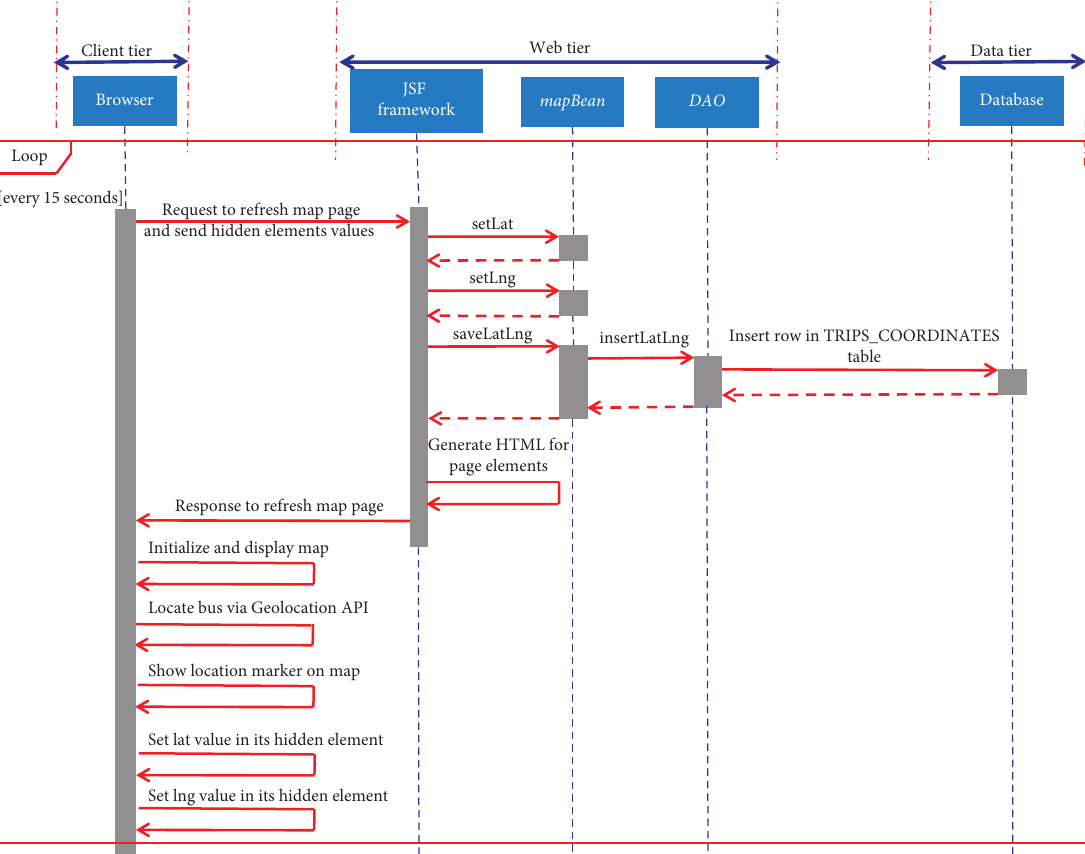
Figure 15: The sequence diagram for the bus trip tracking and recording code